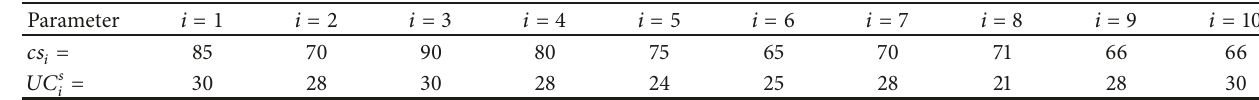
Table 1: Parameters of the base case, associated with suppliers 𝑖 .